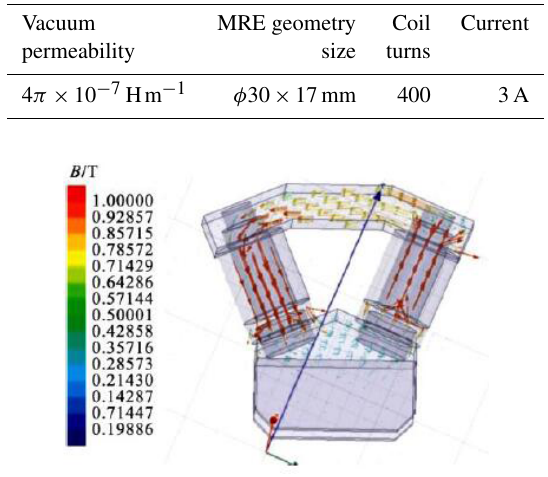
Figure 11. Magnetic circuit simulation